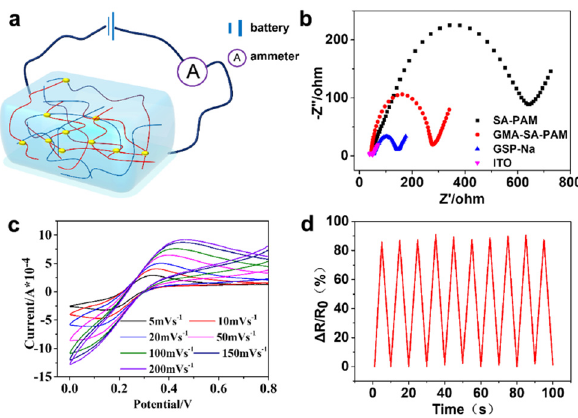
Figure 4: ( a ) Schematic structure of the electrochemistry sensor of the GSP - Na hydrogel. ( b ) The conductive property of the SA - PAM, GMA - SA - PAM, and GSP - Na hydrogels, respectively. ( c ) CV curves at various scan rates of the GSP - Na hydrogels. ( d ) Stability and dur - ability of GSP - Na conductivity hydrogel under stretch ( 100% ) /